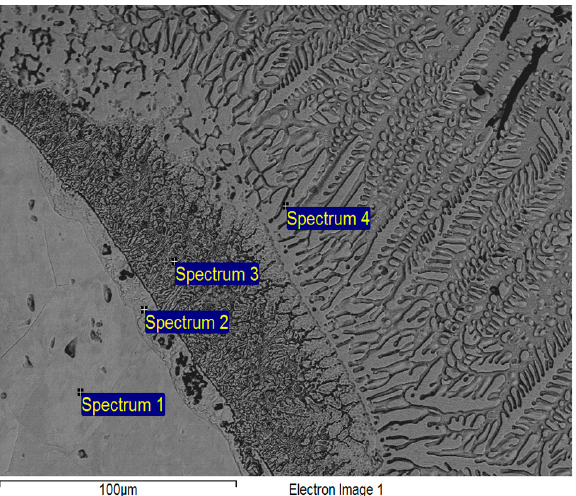
Figure 9. Measurement of chemical composition by EDS analysis (nickel–weld metal interface) (weld 10).